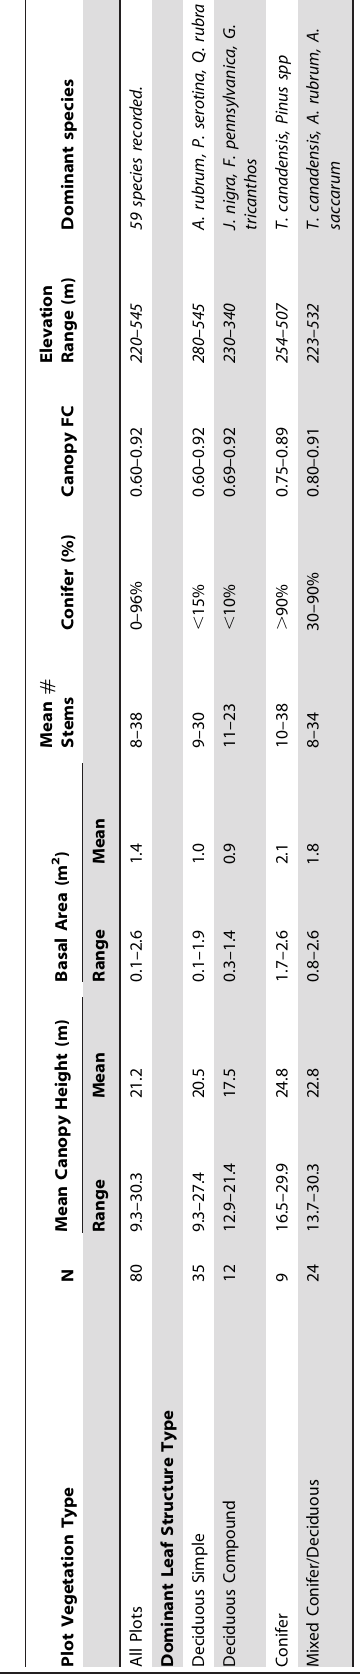
Table 3. Adjusted height values per year in meters for all plots and by plot vegetation leaf structure type.